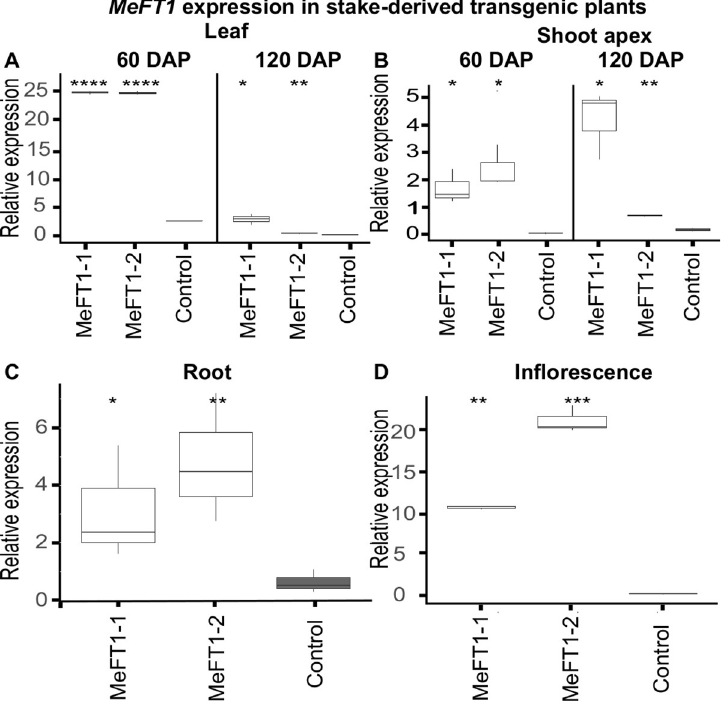
Fig 3. RT-qPCR expression profiling of MeFT1 in multiple tissues of transgenic plant lines MeFT1-1, MeFT1-2 and somatic embryo-derived non-transgenic control. Relative mRNA levels of MeFT1 in ( A ) leaf at 60 and 120 days after planting (DAP), ( B ) shoot apex at 150 DAP, ( C ) root and ( D ) inflorescence at 210 DAP respectively. Data shown is for three independent RT-qPCR reactions each comprising three biological samples and two technical replications per tissue type. Two-way Student’s t test was performed to compare means of transgenic and non-transgenic embryo derived controls. � P � 0.05; �� P � 0.01; ��� P � 0.001, ���� P � 0.0001. ggplot2 of R software was used to construct box plots. The middle line in the box shows the median value. Data ranging from smallest value to lower quartile represents lower whisker while values between upper quartile and largest correspond to upper whisker. Values below and above median represent lower and upper quartile of roughly 1.5IQR